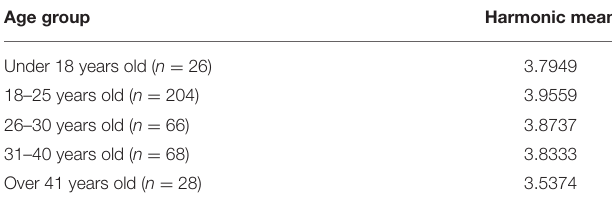
TABLE 6 | Mean difference results.